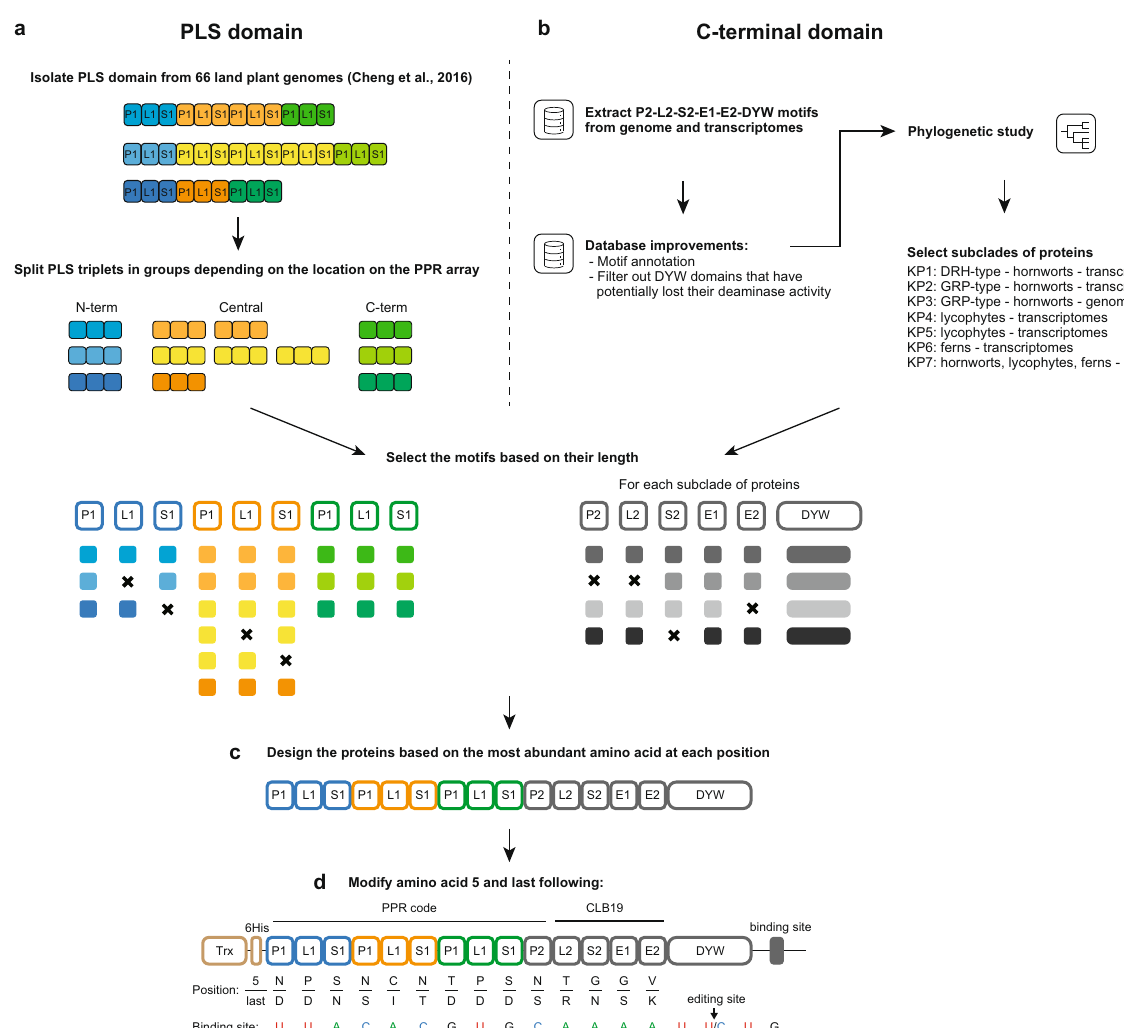
Fig. 1 Schematic depiction of the work fl ow for designing the PLS and C-terminal domains of designer DYW:KP proteins. a The P1L1S1 triplets used for the design of the PLS domain were isolated from land plant genomes and selected based on their location in the PLS domain: the ‘ N-term ’ triplets correspond to the fi rst P1L1S1 triplet in the PLS domain, the ‘ Central ’ triplets are preceded and followed by a P1L1S1 triplet, and the ‘ C-term ’ triplets precede a P2L2S2 triplet. b The C-terminal domains were designed on the P2, L2, S2, E1, and E2 PPR-like motifs and DYW domains isolated in hornworts, lycophytes and ferns transcriptomes and Anthoceros angustus genome. After improving the motif database, a phylogenetic analysis was performed to isolate subclades of proteins. c After selecting the PPR motifs on their average length, a unique PLS domain composed of three P1L1S1 triplets and seven C-terminal domains (one for each subclade of proteins identi fi ed in ( b )) were designed based on consensus sequences. d The amino acids involved in the RNA recognition were mutated to recognize speci fi cally AtrpoA . The DYW:KP proteins overexpressed in Rosetta 2 cells were tagged with an N-terminal thioredoxin (Trx) domain and His-tag (6His). The targeted editing site ( AtrpoA ) is localized downstream of the stop codon. Below each PPR motif, the two amino acids determining the target speci fi city are aligned with the AtrpoA editing site. U/C indicates the editing site. Arrows indicate the design fl